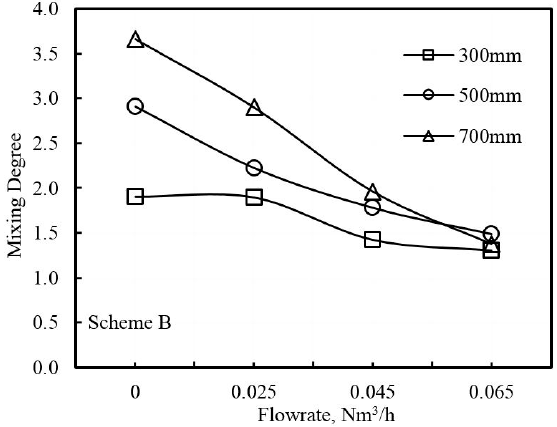
Figure 14. Mixing degree as a function of bottom blowing flowrate using Scheme B.